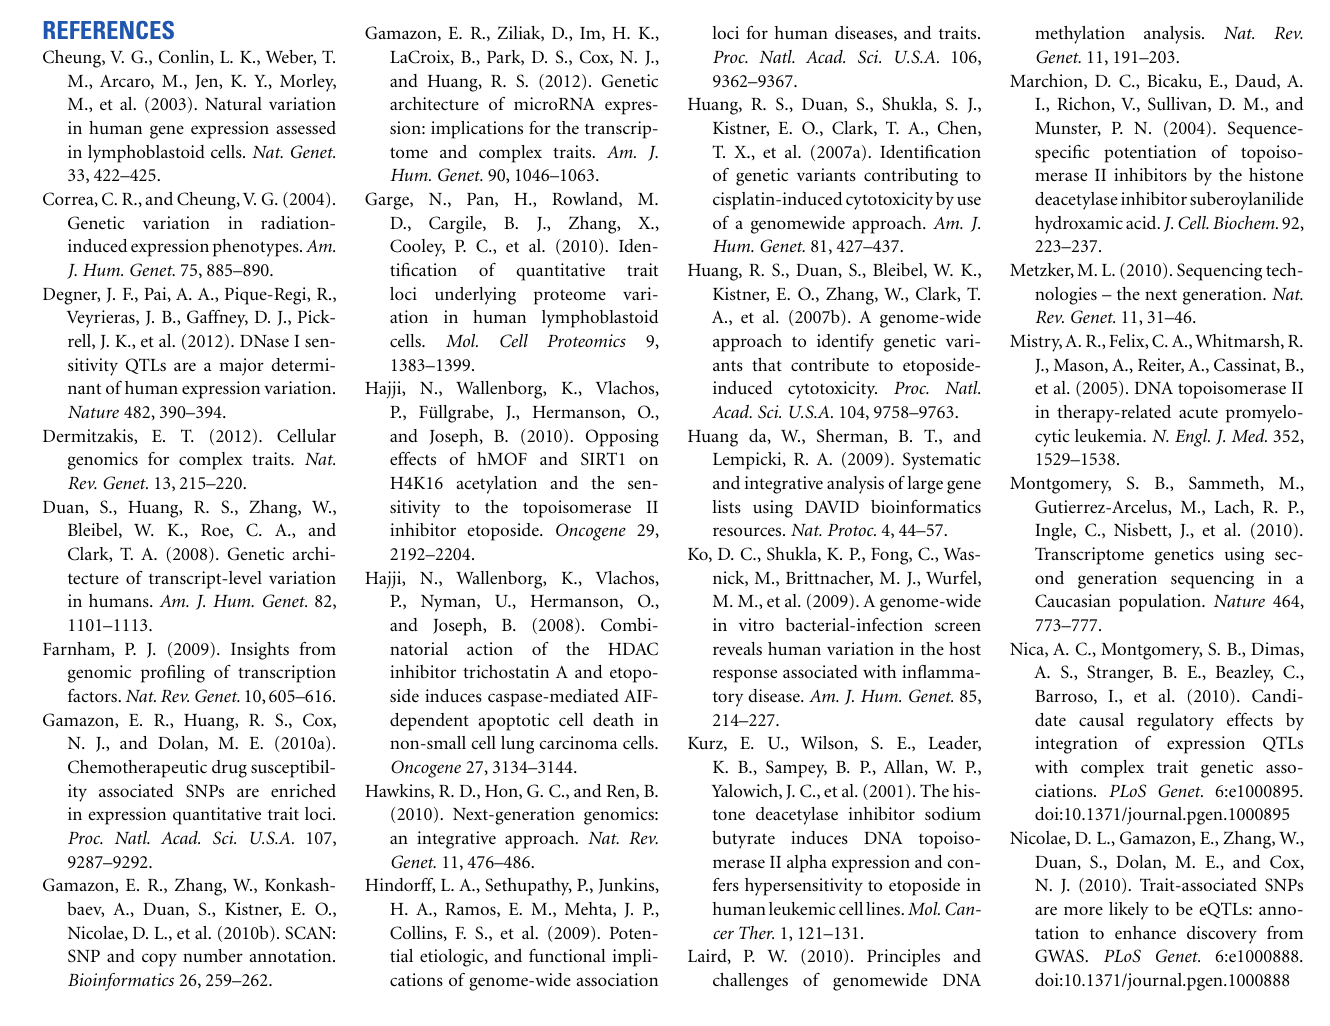
Table S1 |Top gene expression-trait correlations.